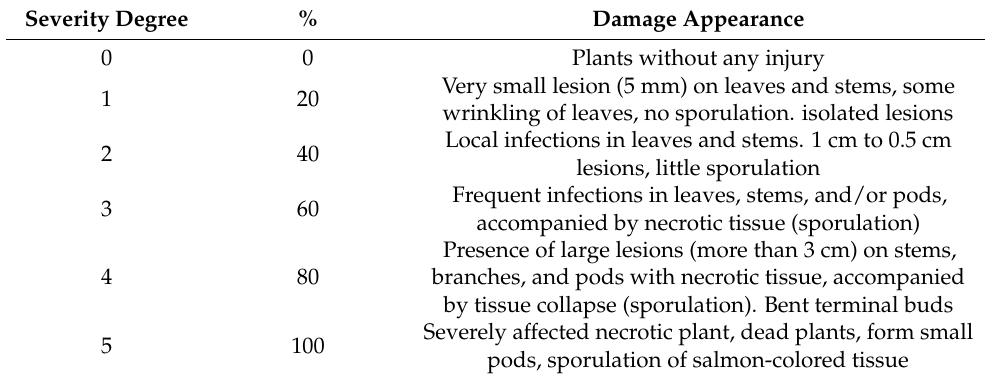
Table 4. The scale of the severity degree and percentage of the disease caused by Anthracnose in the tarwi